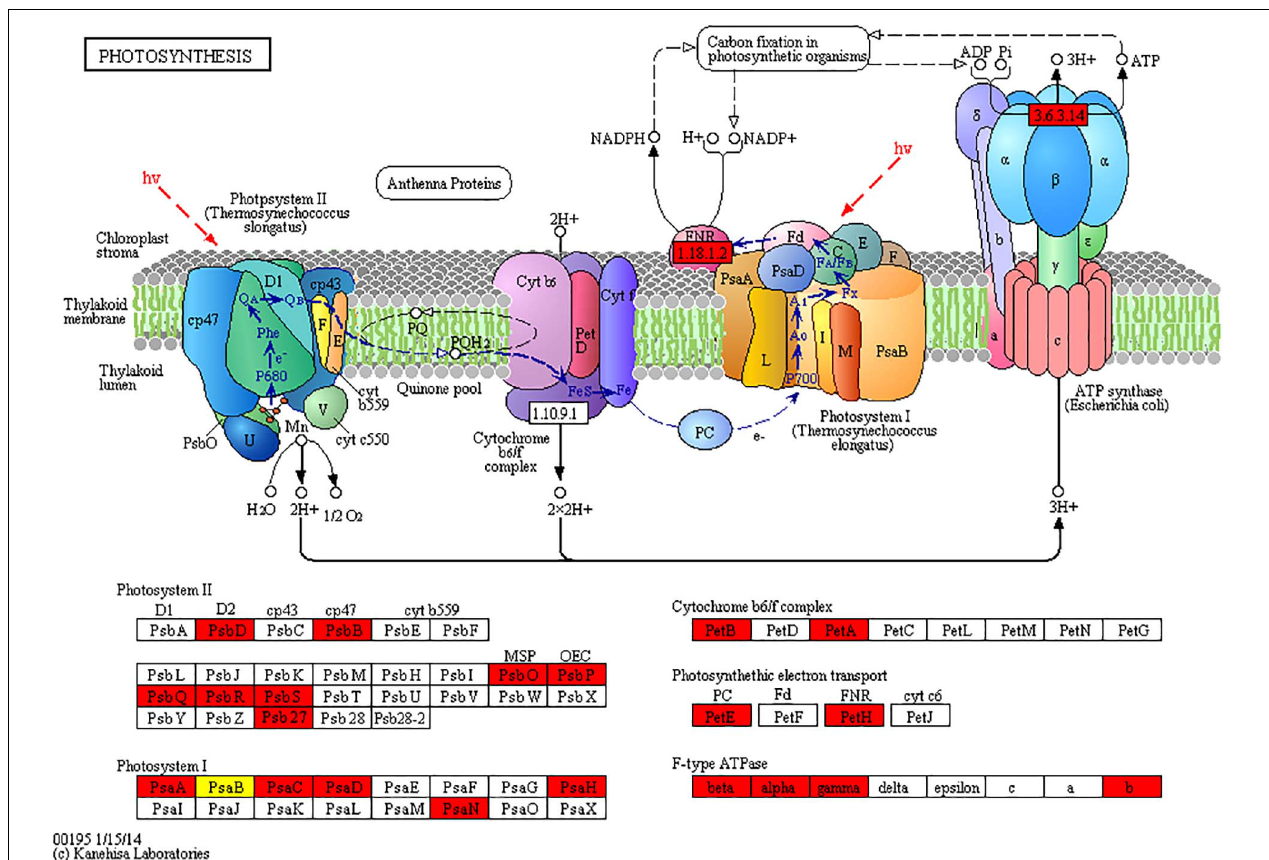
FIGURE 7 | KEGG pathways of significantly enriched photosynthesis. The red highlights mean the acetylated proteins that were significantly upregulated in the photosynthesis pathway of CWMV-infected N. benthamiana plants compared with those of uninfected N. benthamiana (CK) plants. The yellow highlight means that acetylated protein with one lysine site downregulated and one sites upregulated in CWMV-infected